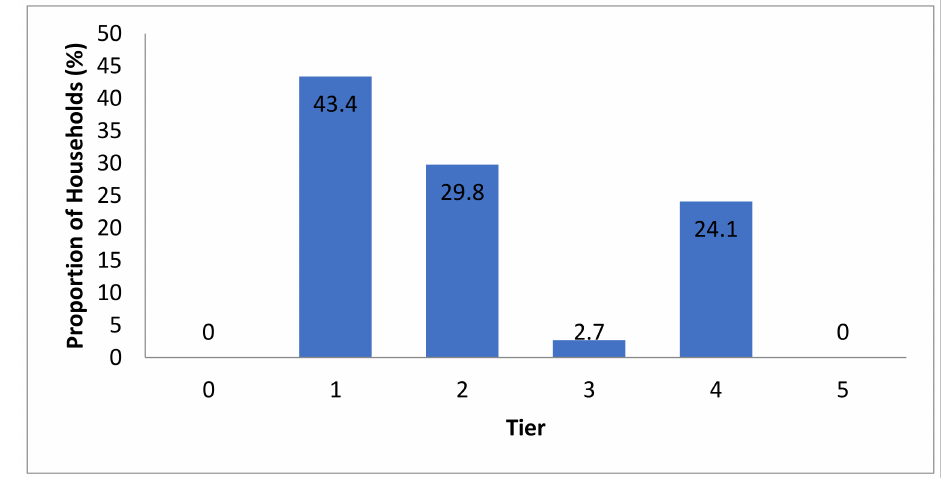
Figure 5. Overall cooking energy access